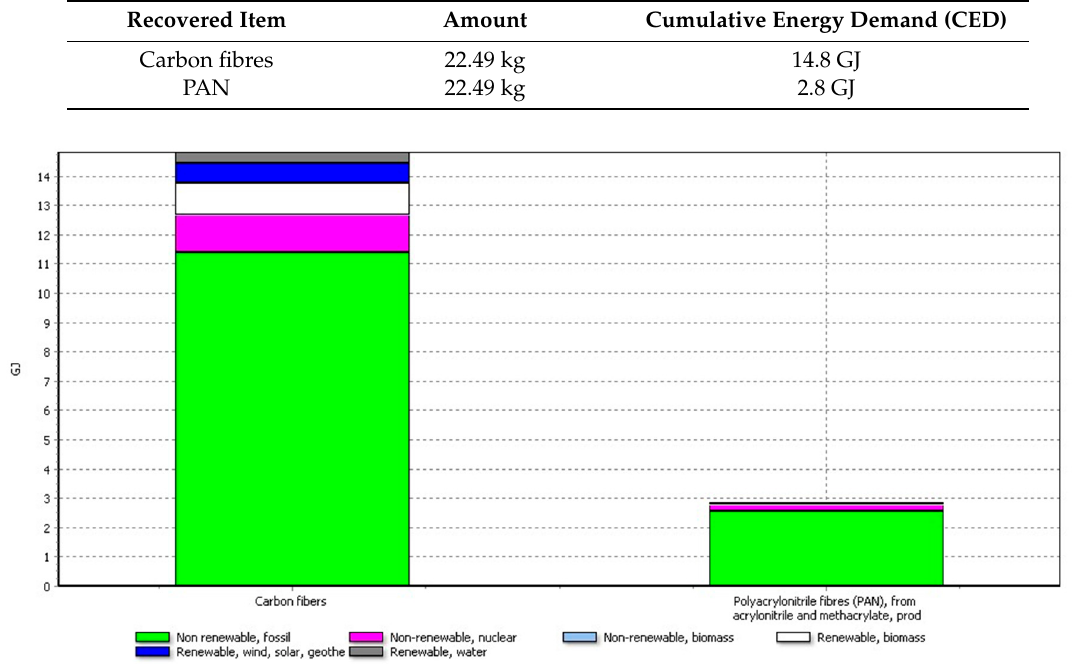
Figure 9. Cumulative energy demand that is required to produce Carbon fibres and PAN. Data for PAN were taken from the Ecoinvent database included in SimaPro. For CFs, the energy consumption was taken from literature.